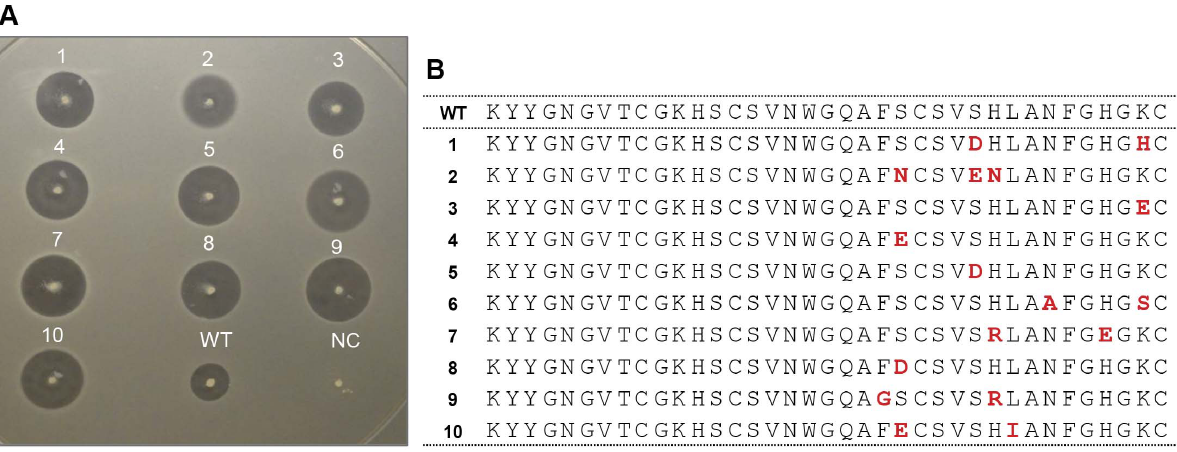
Figure 2. Activities and amino acid sequences of ten Pln-423 mutants tested against L.innocua 33090. ( A ) Clear zones indicate growth inhibition of the tester strain due to presence of active peptides produced by host colonies in the center. Wild-type Pln-423 (WT) and NC (negative control with no AMP expression) was included as controls. ( B ) Corresponding amino acid sequences of the mutants tested in A (mutations are shown in red).